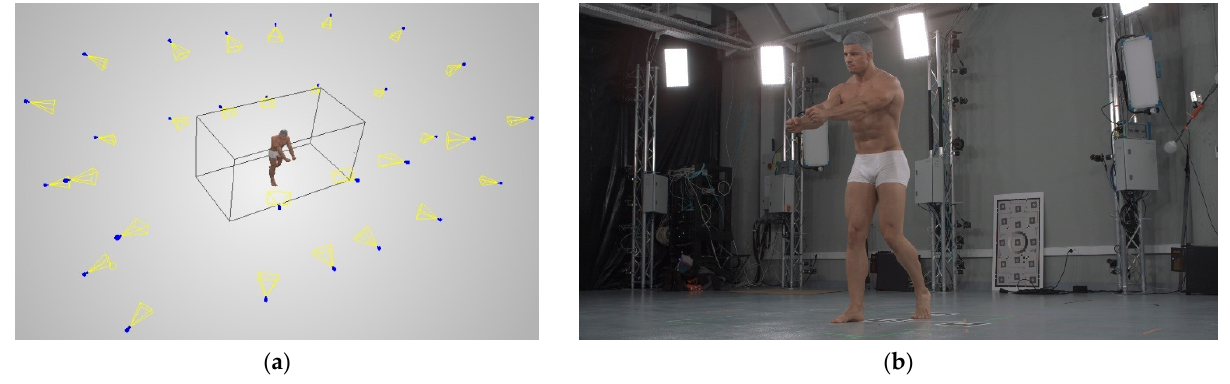
Figure 18. The measurement system used for 3D reconstruction of real data: ( a ) camera setup with measurement region (black cuboid) and example human body reconstruction, ( b ) image captured by an example camera using the measurement system.